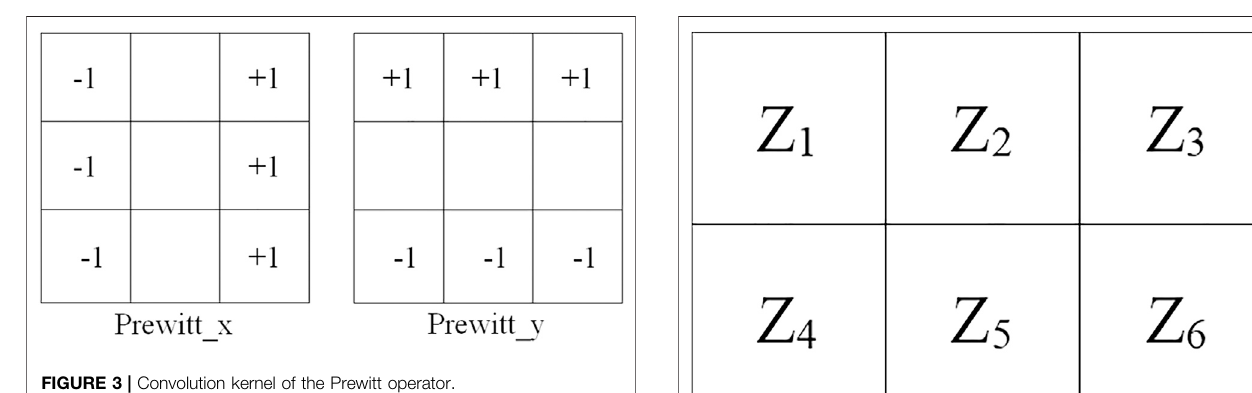
FIGURE 3 | Convolution kernel of the Prewitt operator.